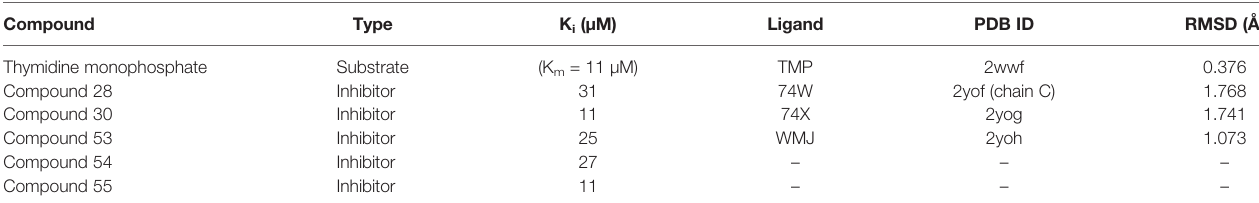
PDB, Protein Data Bank; RMSD, root mean square deviation.